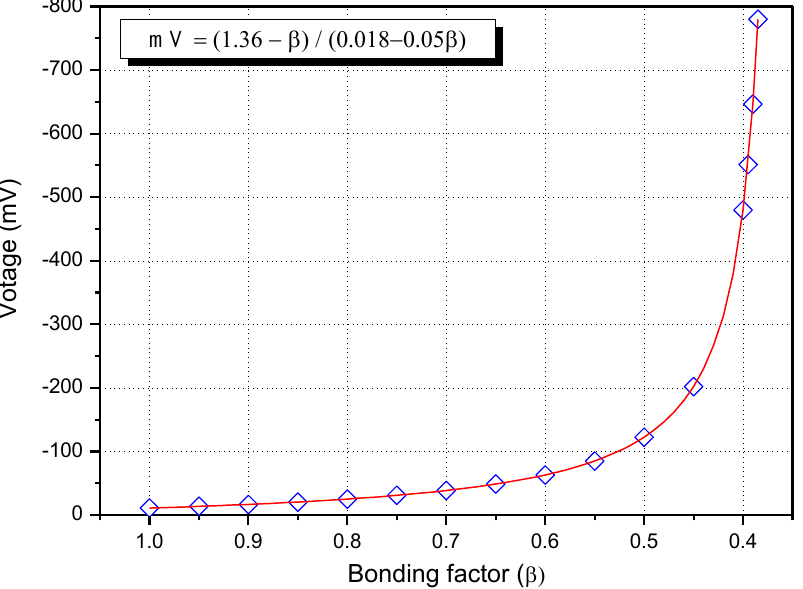
Figure 16. Relationship between bonding factor ( β ) and average potential difference in terms of voltage (mV) of flexural beam specimens.